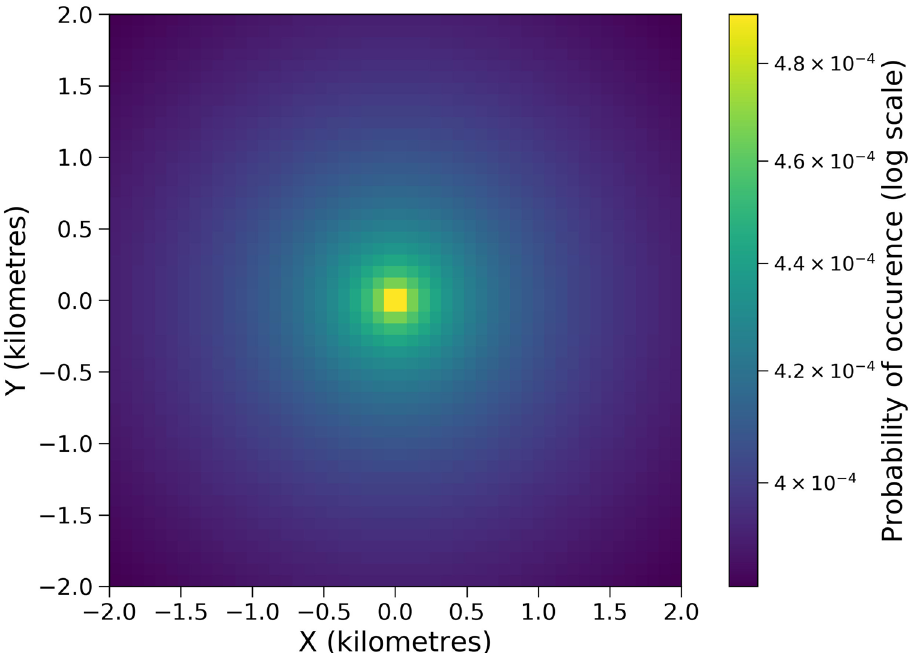
Figure 4. The steady-state probability distribution from the Fokker–Planck equation for GH1Br without using the repulsive terms. The probabilities are very similar when compared to Fig. 11b that includes data for repulsive locations.